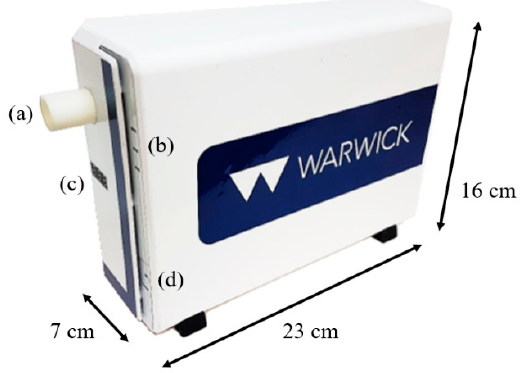
Figure 4. WOLF Breath E-nose: ( a ) Mouthpiece holder; ( b ) LED status indicators; ( c ) Sampling tube temperature indicator; ( d ) Sampling button.